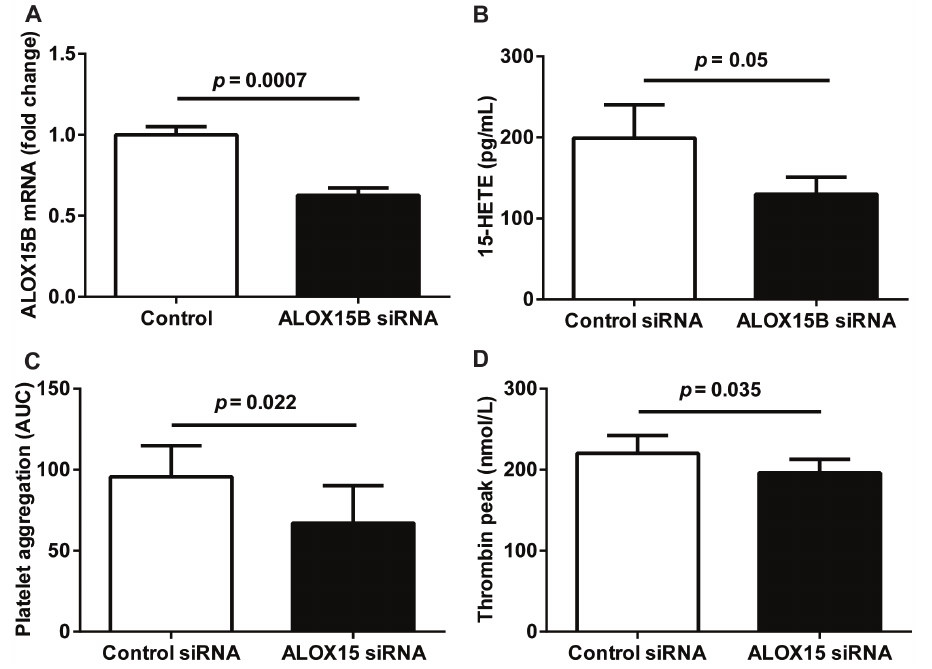
Figure 4. ALOX15B knockdown reduces platelet aggregation and thrombin generation. Primary human monocyte-derived macrophages were transfected with non-silencing control siRNA or ALOX15B siRNA and incubated for 24 hours in ischemia. (A) ALOX15B mRNA expression in macrophages transfected with control or ALOX15B siRNA. ( B ) 15-HETE production in cell lysates from macrophages transfected with control or ALOX15B siRNA. ( C ) Area under the curve (AUC) of platelet aggregation measured using cell lysates from macrophages transfected with control or ALOX15B siRNA. ( D ) Peak thrombin value measured in pooled normal plasma incubated with cell lysates from macrophages transfected with control or ALOX15B siRNA. Data are mean 6 SEM from 4 independent experiments (i.e. macrophages from 4 blood donors) analyzed in duplicate.